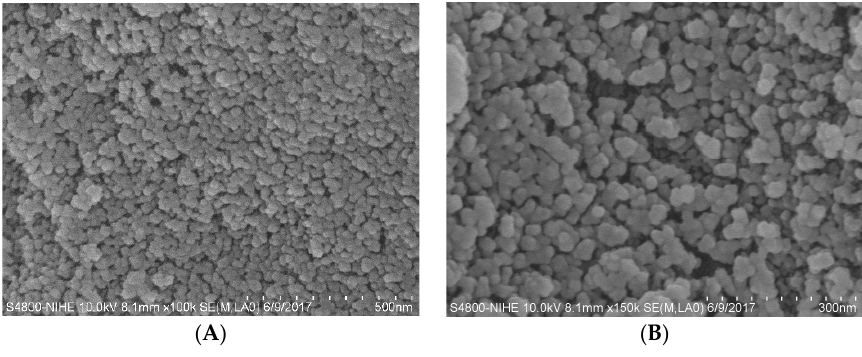
Figure 5. SEM images of SiO 2 nanoparticles at different scales: ( A ) 500 nm; and ( B ) 300 nm.